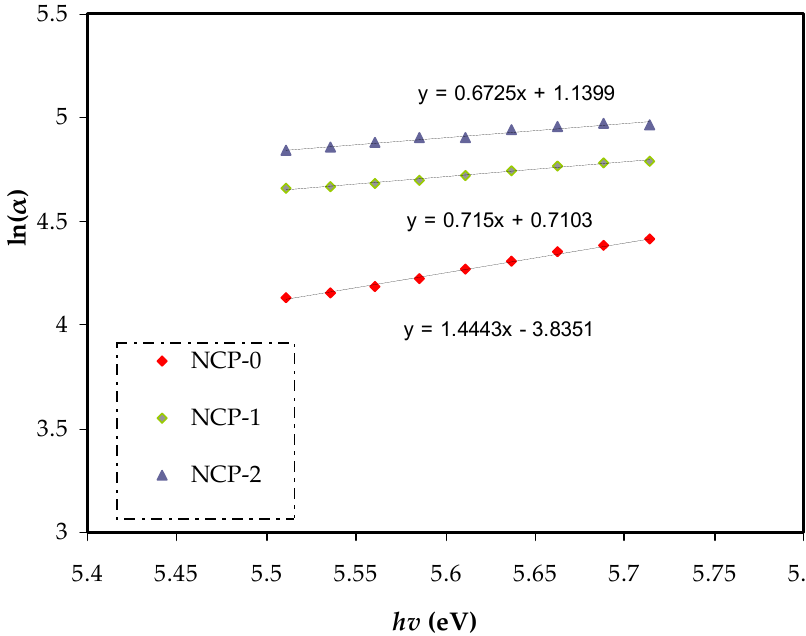
Figure 13. Urbach plot for NCP-0 and composite films. Table 3. Urbach energy for pure PEO and PEO doped solid polymer films.